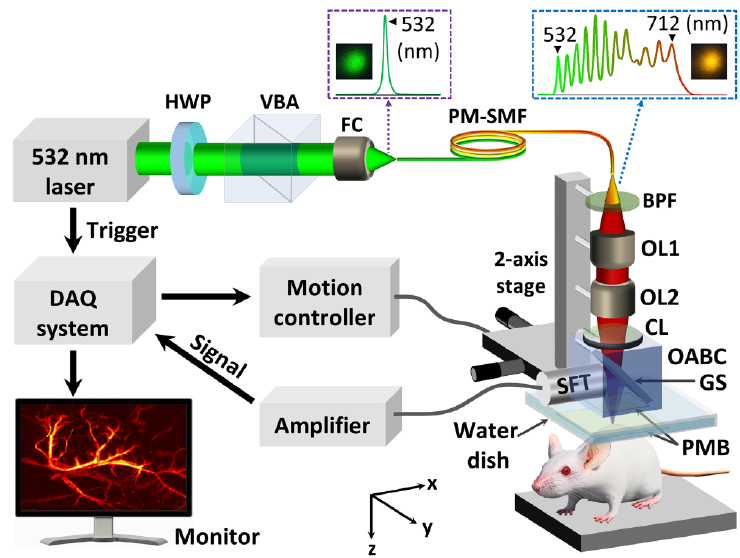
Figure 8. Schematic of tunable-color OR-PAM system. Reprinted from Bui et al . , Sci. Rep., 2016, 8,1: 018-20139-0 [26], with permission of Spring Nature.